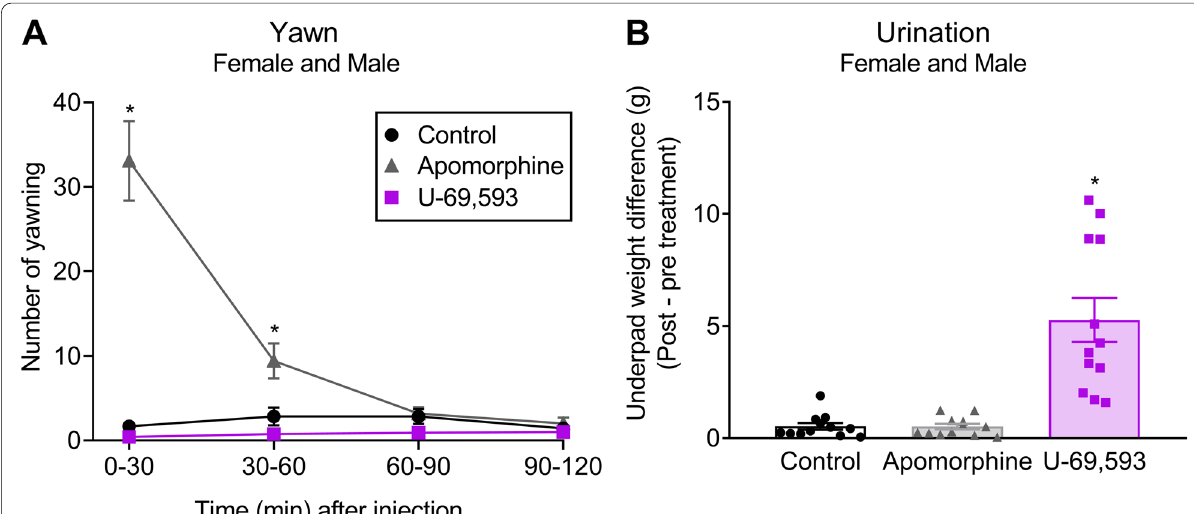
Fig. 1 Systemic KOR agonist, U-69,593, failed to induce yawning behavior but increased urination in both female and male rats. A The number of yawning events and, B the increase in urination were evaluated for 120 min after a single subcutaneous administration of U-69,593 at 0.56 mg/kg, apomorphine at 0.05 mg/kg (a non-selective dopamine agonist used as a positive control for yawning) and vehicle-control. The number of yawning was quantified in 30-min intervals. Urination was quantified as the difference between the weight of the individual absorbable underpads before drug administration and 120 min after testing. Female and male data were combined. Data are presented as mean two-way ( A ) or one-way ( B ) ANOVA followed by Tukey’s multiple comparison test with * representing p < 0.05 in comparison with the control group ( n 12; 6 females/group and 6 males/group) =